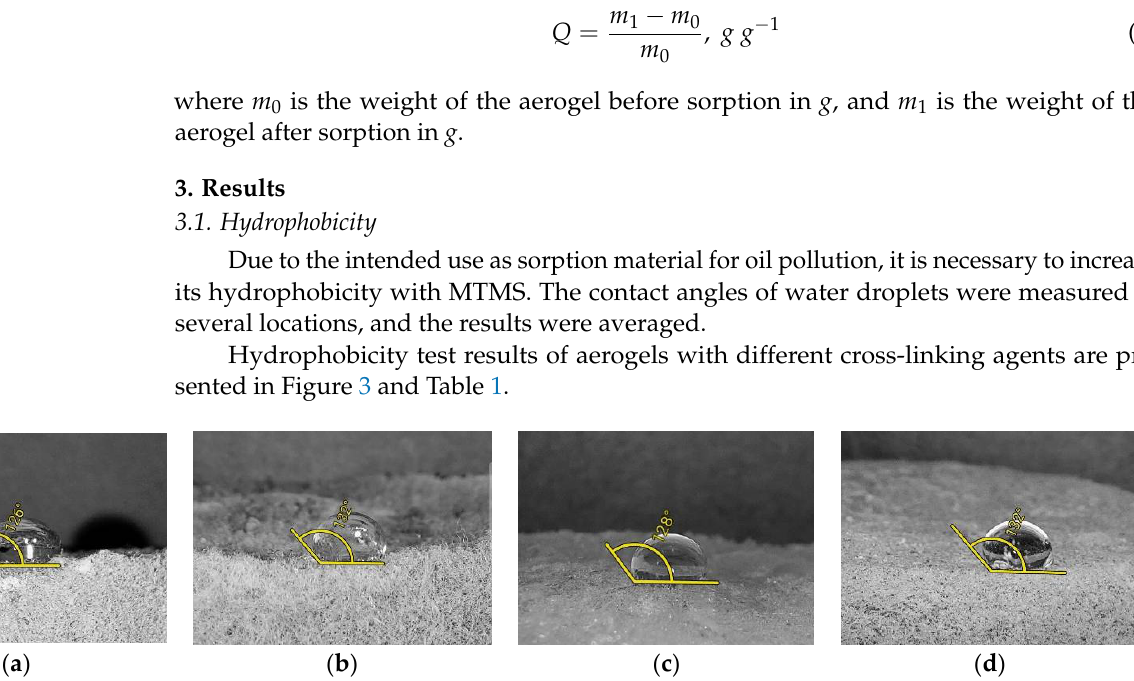
Figure 3. Photographs of an aerogels with different cross-linking agents and the biggest contact angles of water droplets: ( a ) control samples (polyester resin), ( b ) cellulose acetate, ( c ) starch and ( d ) starch and cellulose acetate. Table 1. Hydrophobicity test results of aerogels.